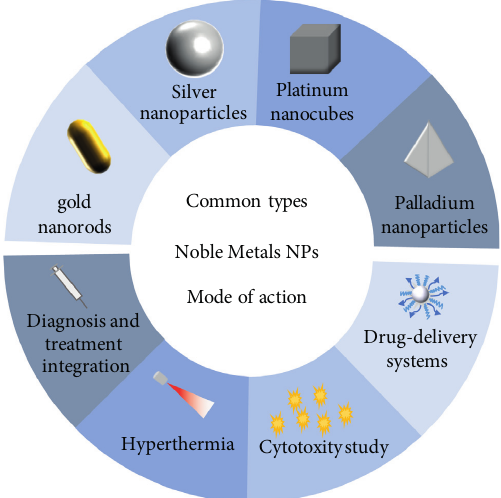
Figure 1: Types and mechanisms of noble metal nanoparticles for cancer